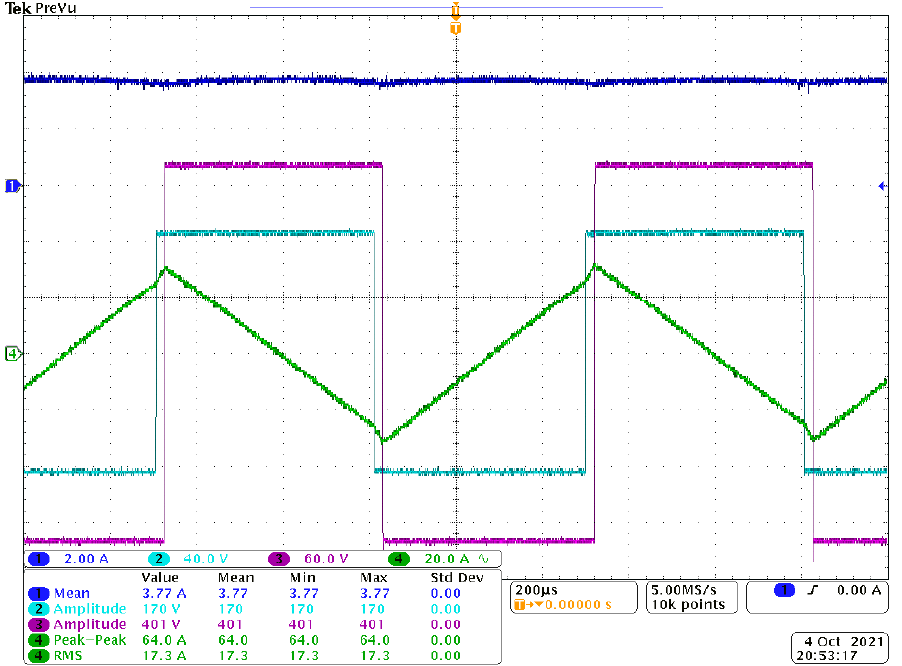
Figure 13. DAB operation at medium power under the SPS